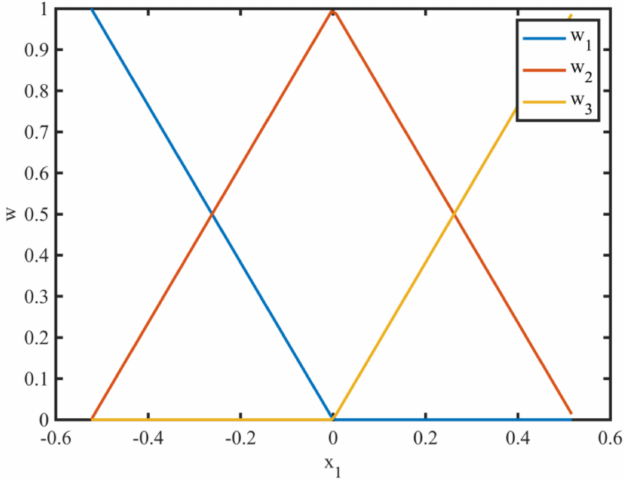
Figure 3. Diagram showing degree of membership